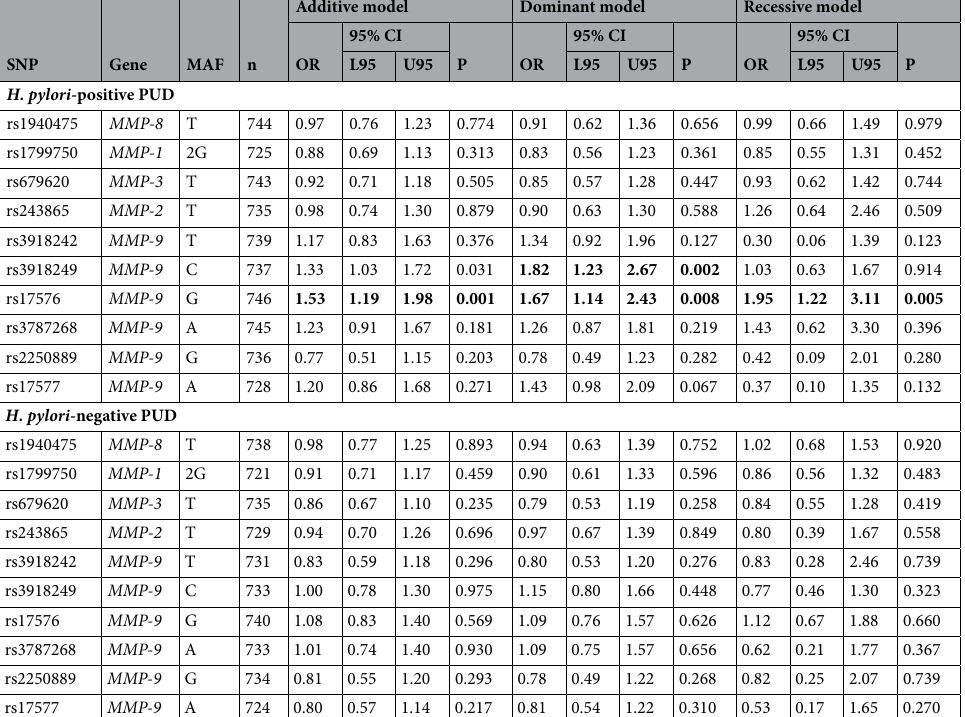
Table 3. Associations of the MMP gene polymorphisms with H. pylori -positive and H. pylori -negative PUD. All results were obtained after adjustment for covariates. p values < 0.017 are shown in bold. OR odds ratio, 95% CI 95% confidence